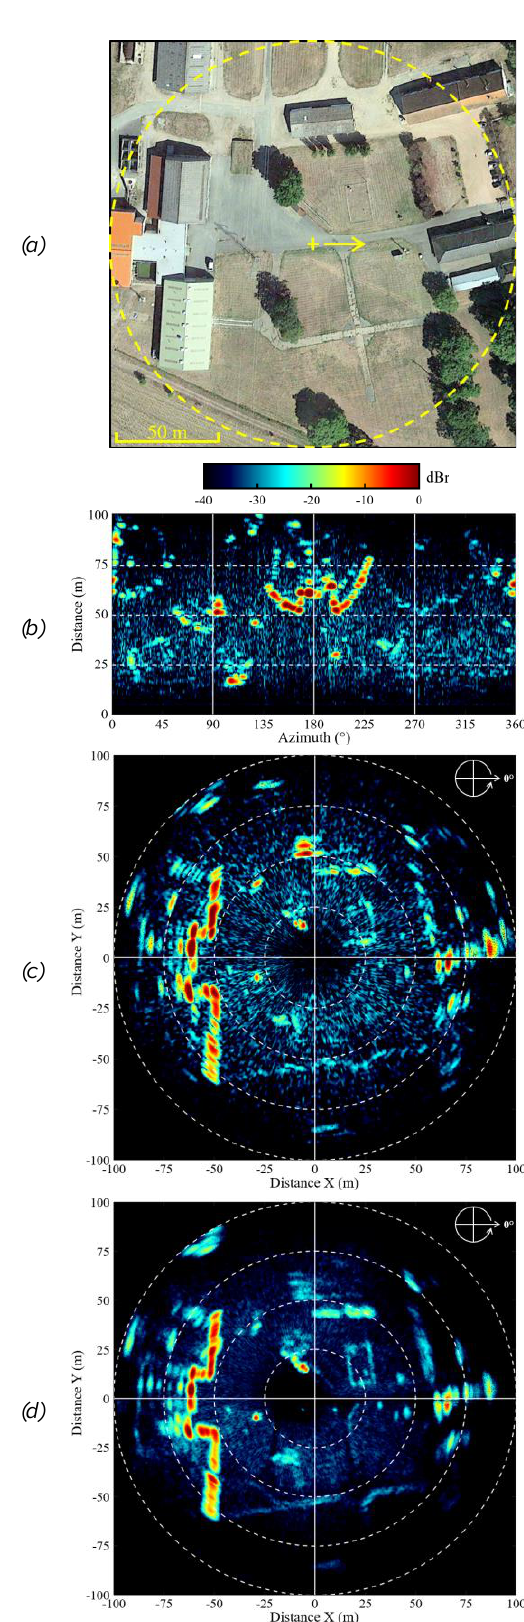
Figure 3. Radar image construction. (a) Aerial image of the test zone. Yellow cross and arrow: position and orientation of the robot. (b) Raw radar data in polar coordinates. (c), (d) Radar images in Cartesian coordinates, without and with anti-speckle filter Figure 6 and Figure 7. The current version of R-SLAM algorithm